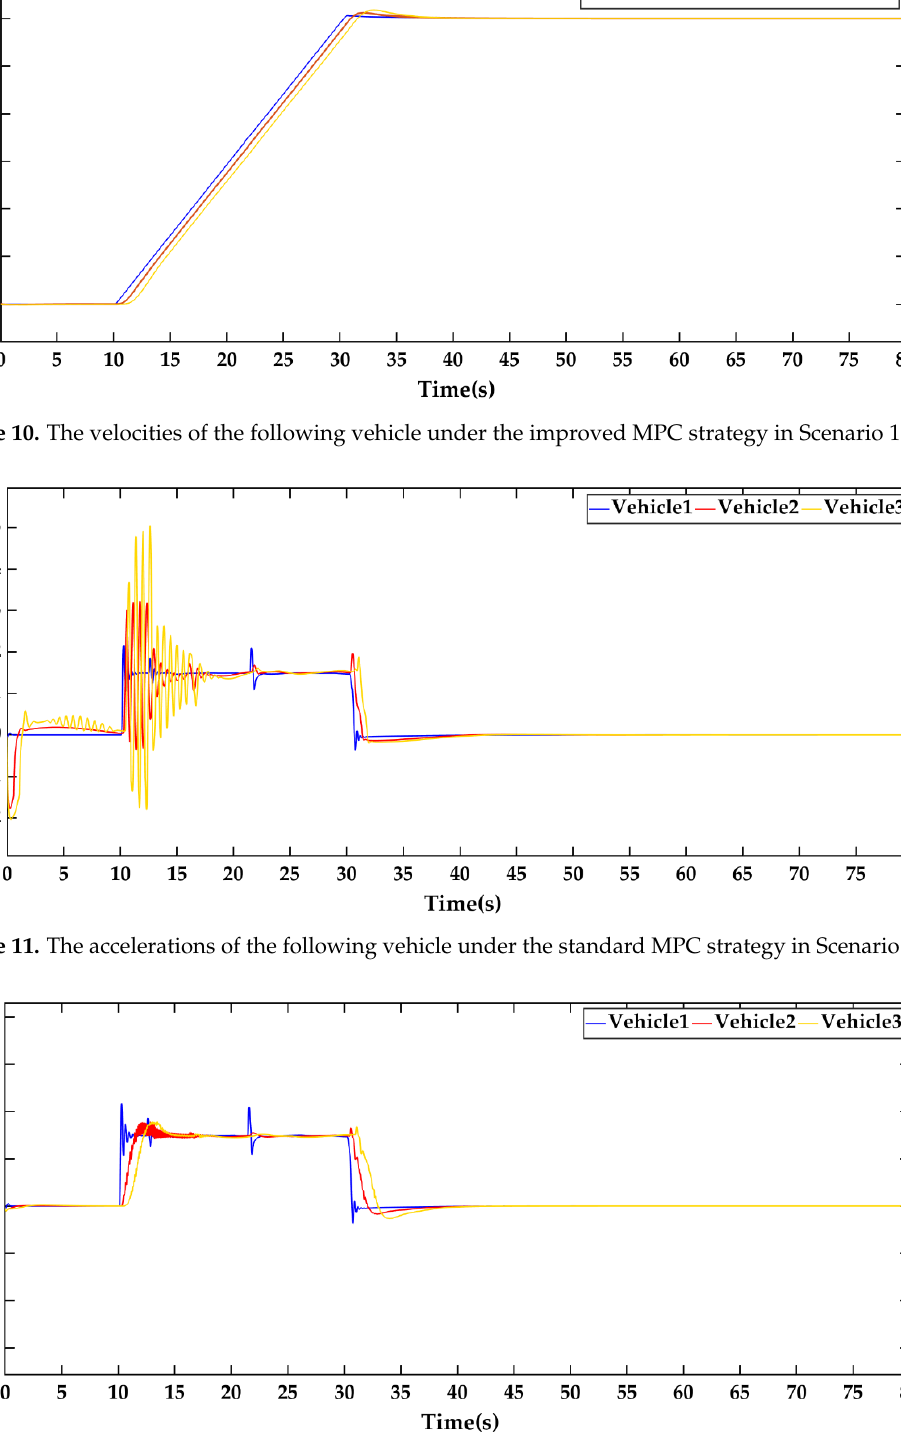
Figure 12. The accelerations of the following vehicle under the improved MPC strategy in Scenario 1.